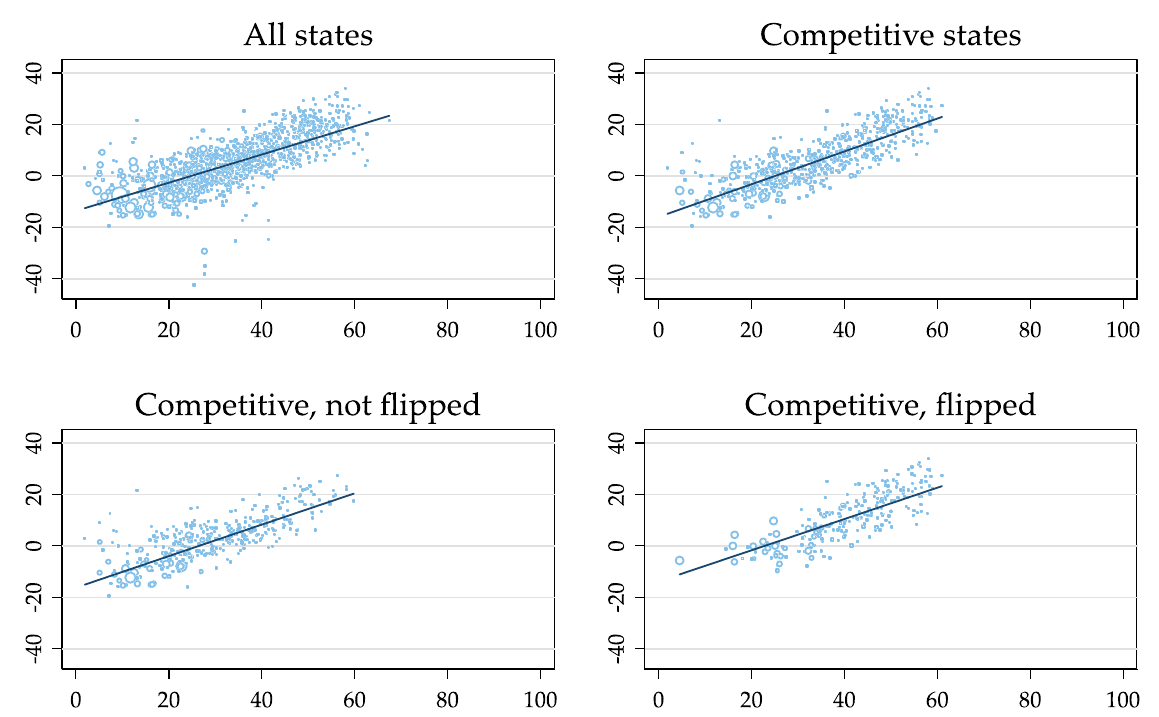
Figure 2: Trump’s 2016 gain by percentage of the voting population that is WONH and working class (broad